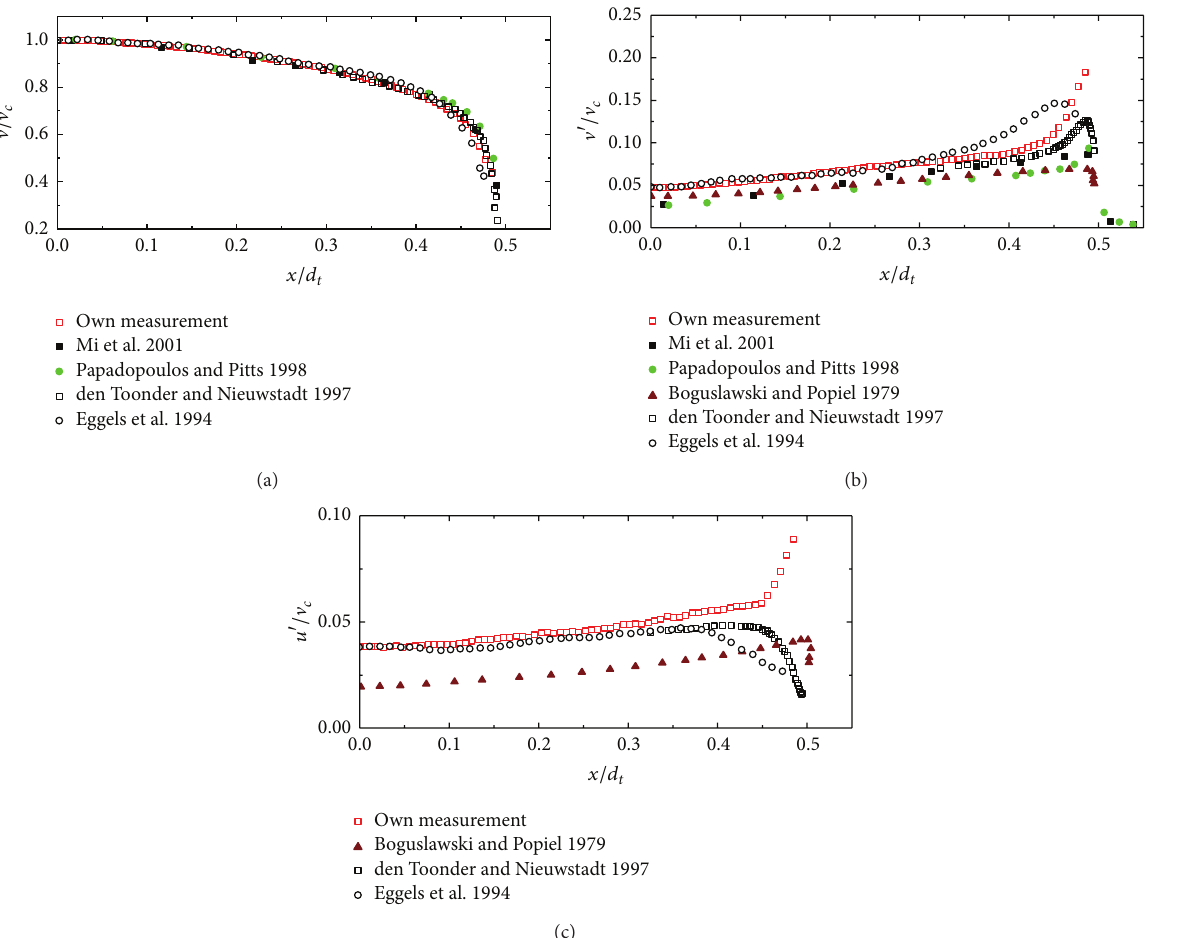
Figure 9: Comparison of mean and turbulence statistics ( V , V 󸀠 ,𝑢 󸀠 ) of own tube exit measurements with straight pipe tube exit measurements from the literature and turbulent pipe flow